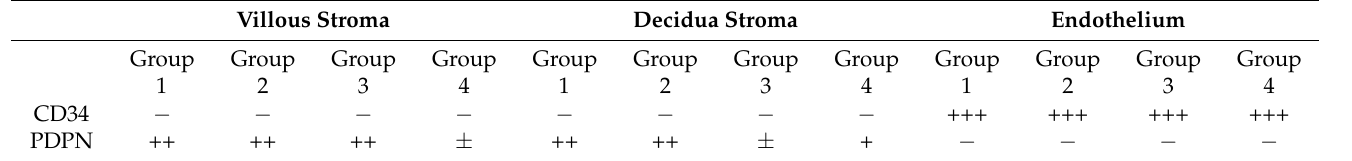
Figure 1. Histology of placental samples at different gestational periods and stained with hematoxylin and eosin is depicted in the first row of the panel. In the second and third rows of the panel, exemplificative immunohistochemical stainings for CD34 and podoplanin are shown. An asterisk indicates areas of podoplanin expression with the characteristic plexiform network pattern around the villous nucleus of the fetal vessels (original magnification ×5). Table 3. CD34 and PDPN immunohistochemistry reactivity in normal human placentas and SARS- CoV-2